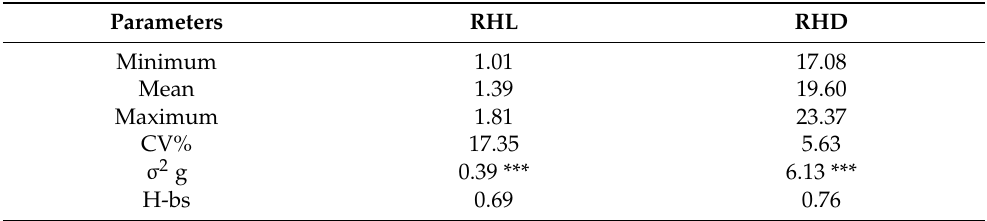
Table 1. Descriptive statistics and analysis of variance of root hair length (RHL) and root hair density (RHD) of twenty-four spring wheat